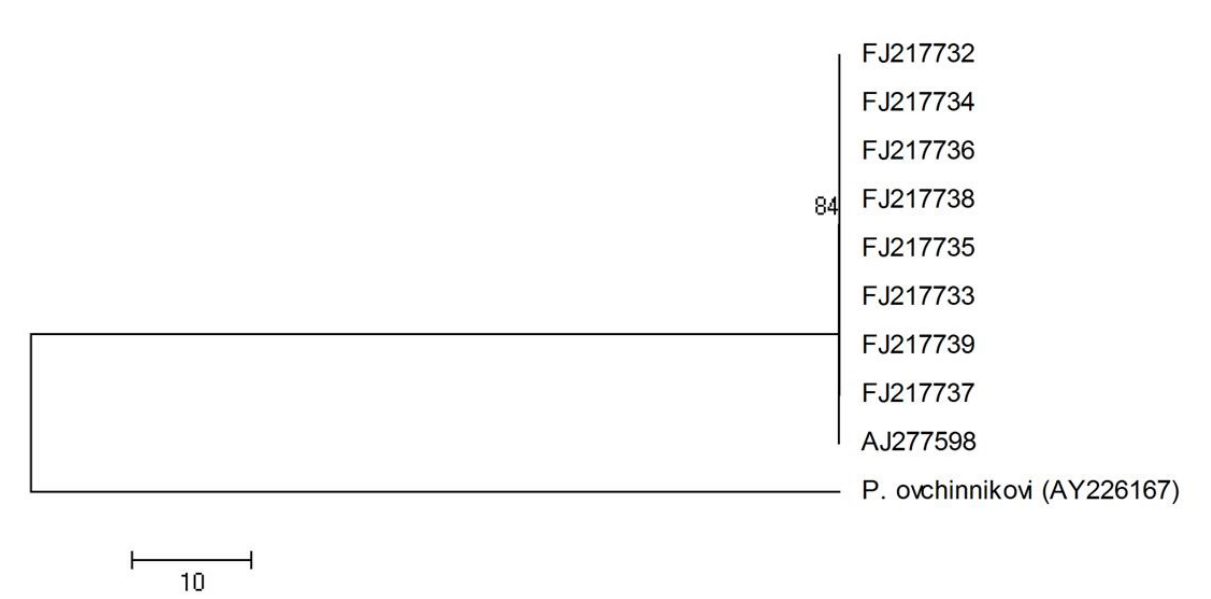
Figure 1. The neighbor-joining tree was conducted in MEGA4. Pseudochactas ovchinnikovi was selected as outgroup. All sequence data are closely related to the outgroup